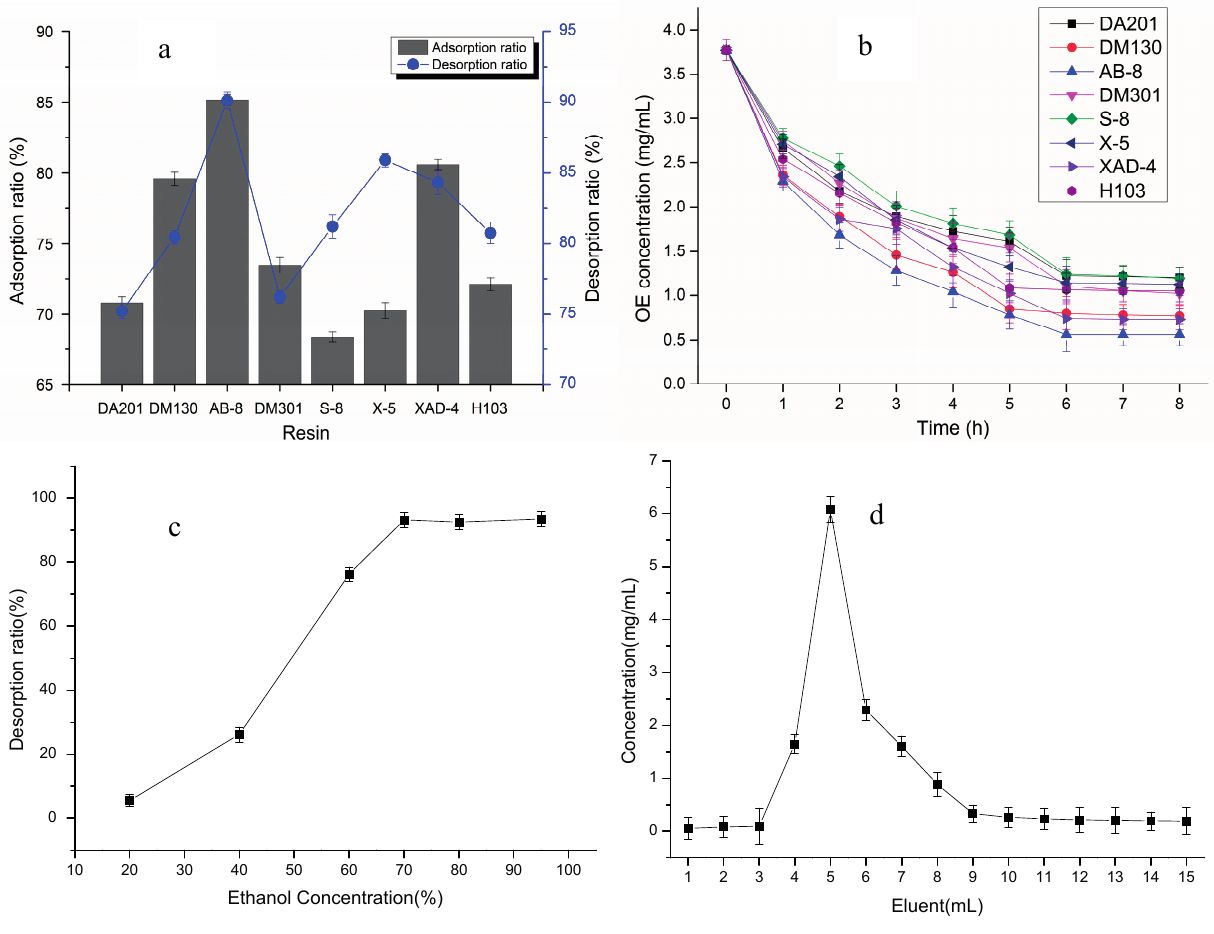
Figure 1. Adsorption, desorption performance, kinetic curves, elution effect of different ethanol concentration and dynamic adsorption curve of resins ( n = 3). ( a ) adsorption and desorption performance of resins; ( b ) adsorption kinetic curves of resins; ( c ) elution effect of different ethanol concentration; ( d ) dynamic adsorption curve of